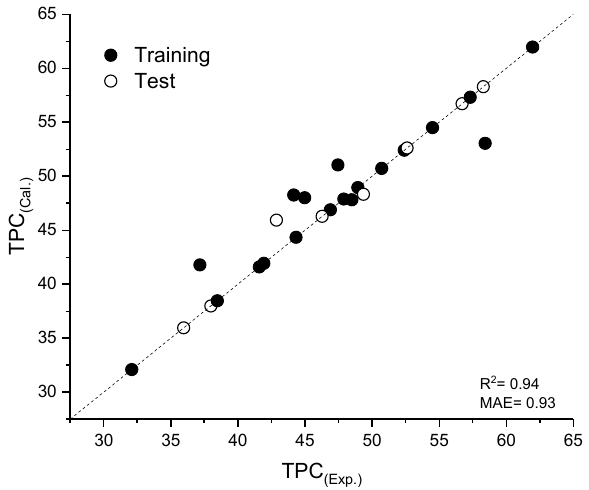
Figure 1. Parity plot of the experimental and predicted TPC yield .